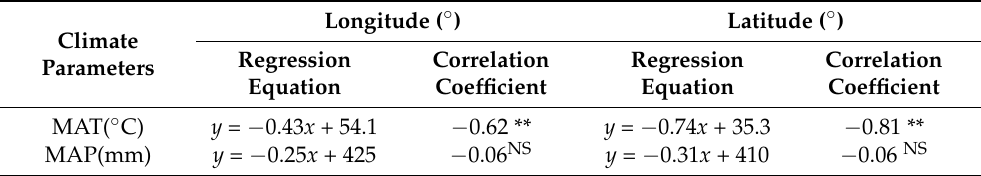
Table 2. Regression analysis of climate parameters and geographic